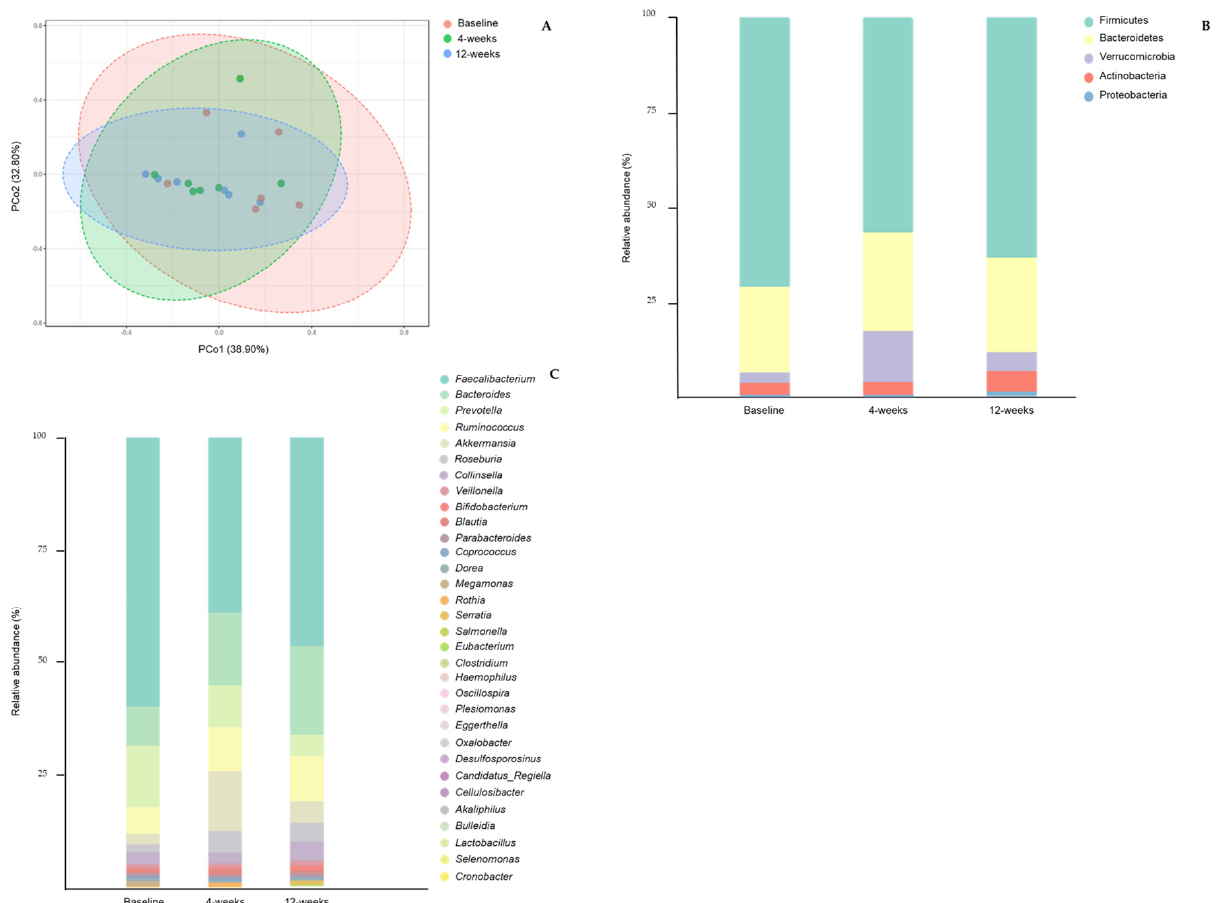
Figure 2. Clustering of fecal bacterial genera communities by principal component analysis (PCoA) ( A ). Data are plotted according to the first two principal components, which explain 32.80% (PCo1) and 38.90% (PCo2) of gut microbiota composition variation at 4 weeks and 12 weeks of the intervention. Each point represents one sample. Gut microbiota composition considering phylum ( B ) and genera ( C ) level at baseline, 4 weeks, and 12 weeks after intervention. Bars represent the average relative abundance of each bacterial phylum/genus. Each phylum/genus is represented by a different